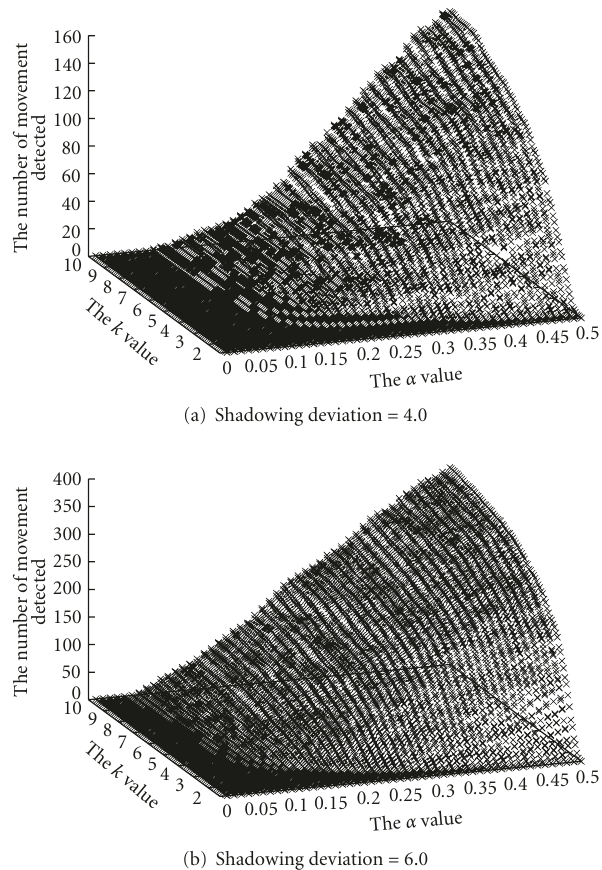
Figure 5: Relationship among α , k , and number of detected motions (DIFthresh1 = − 1, DIFthresh2 = 1, Sample Number = 1000).